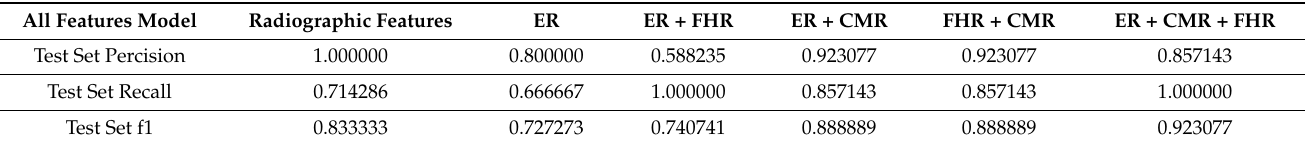
Table 4. Performance Comparison Confusion Matrix Diagnosis Index.